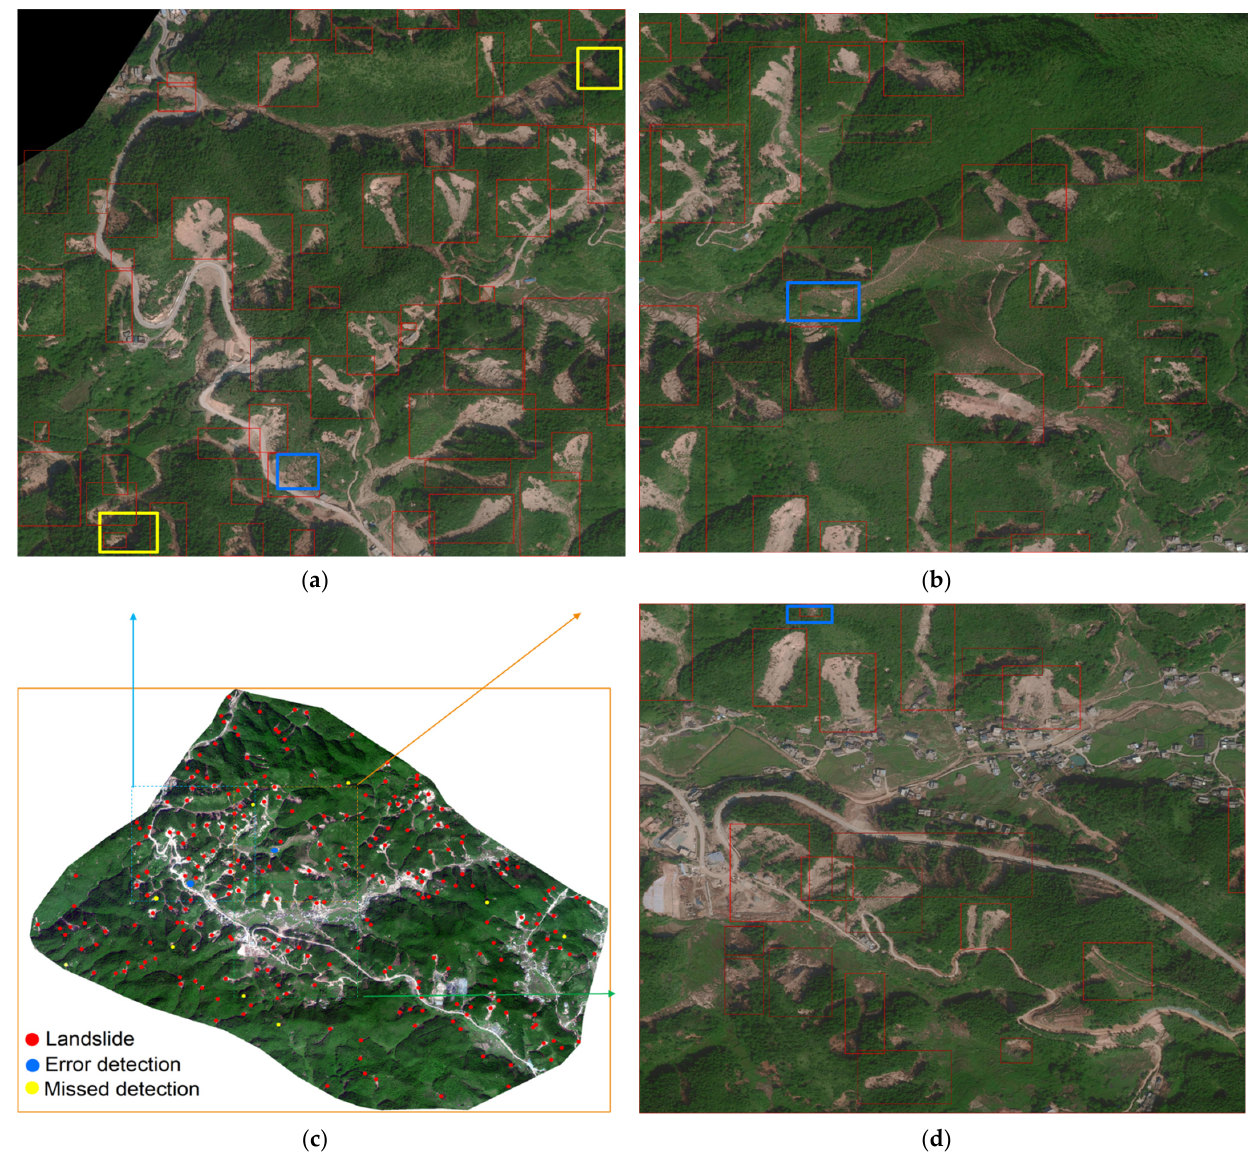
Figure 14. Detection results of Mibei area by YOLOX-Pro(M). ( a , b , d ): Detection results of dense areas of landslides. ( c ): Landslide detection results for the Mibe area. The red, blue, and yellow points indicate the correct, erroneous, and missed landslide detection locations, respectively. The red rectangles mark the landslide boundaries, which the model automatically detects. The yellow and blue rectangular boxes are the model’s missed and erroneously detected landslides, respec- tively.